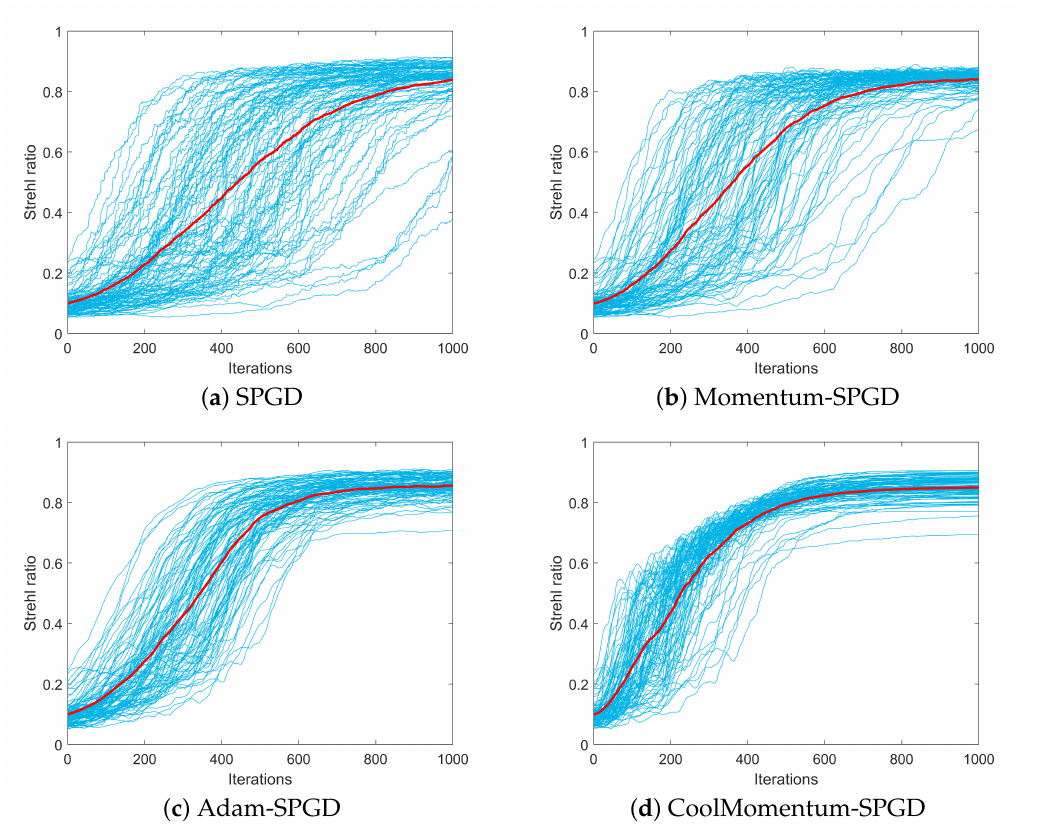
Figure 4. Wavefront aberration correction and the corresponding far-field point spread function (PSF) of a typical phase screen generated under turbulence strength D/r0 = 10. Four different iterative opti- mization algorithms are adopted, respectively. The number of iterations is set to 400. ( a ) Uncorrected wavefront. ( b ) Wavefront corrected with SPGD. ( c ) Wavefront corrected with Momentum-SPGD. ( d ) Wavefront corrected with Adam-SPGD. ( e ) Wavefront corrected with CoolMomentum-SPGD. ( f – j ) The corresponding PSFs of wavefront ( a – e ), respectively.